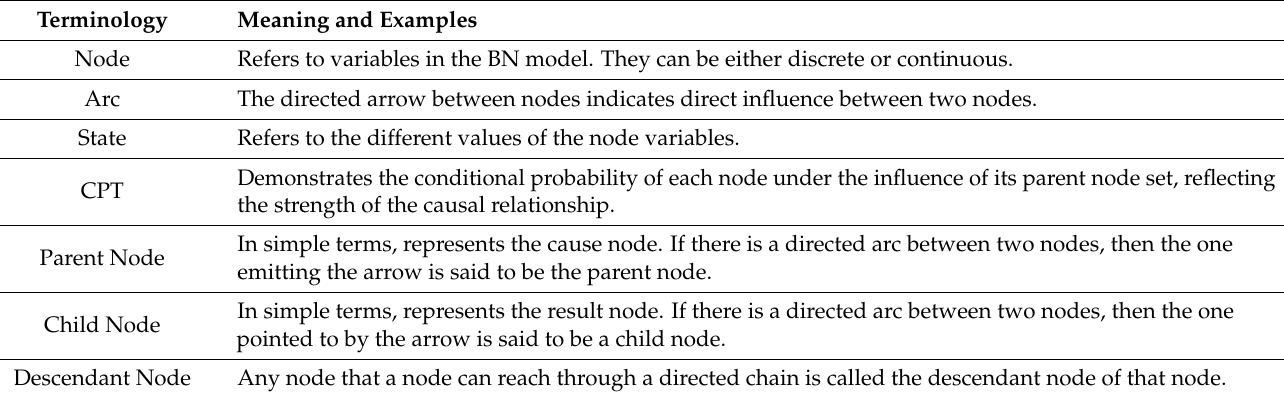
Table 1. Explanation of terms related to Bayesian